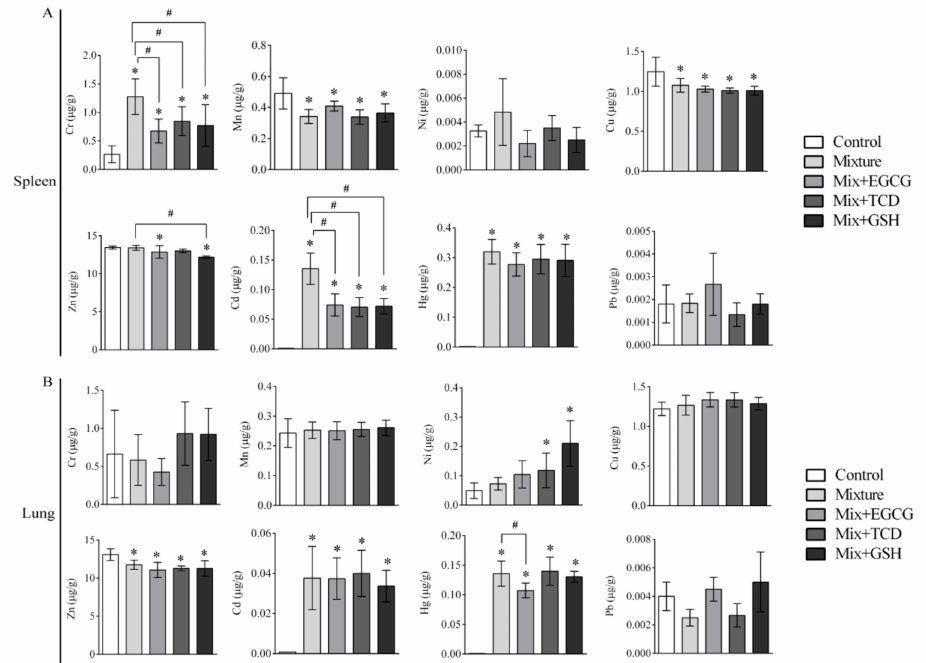
Figure 4. Contents of eight heavy metals in the spleen and lung of SD rats. Bars represented contents of eight heavy metals (ug) in per gram of organs; ( A ) Contents of eight heavy metals in the spleen of SD rats; ( B ) Contents of eight heavy metals in the lung of SD rats; n = 6 rats / each group; Results were presented as means ± SD; One-way ANOVA and LSD-t test were performed; * p < 0.05, vs. the control group (Mixture, Mix + EGCG, Mix + TCD, Mix + GSH compared with the control group); # p < 0.05, vs. the Mixture group (Mix + EGCG, Mix + TCD, Mix + GSH compared with the Mixture group); Mix, Mixture. Table 6. The contents of eight heavy metals in the serum detected by ICP-MS ( n = 30). Element ( µ g / L) Group F p Control Mixture Mix + EGCG Mix +